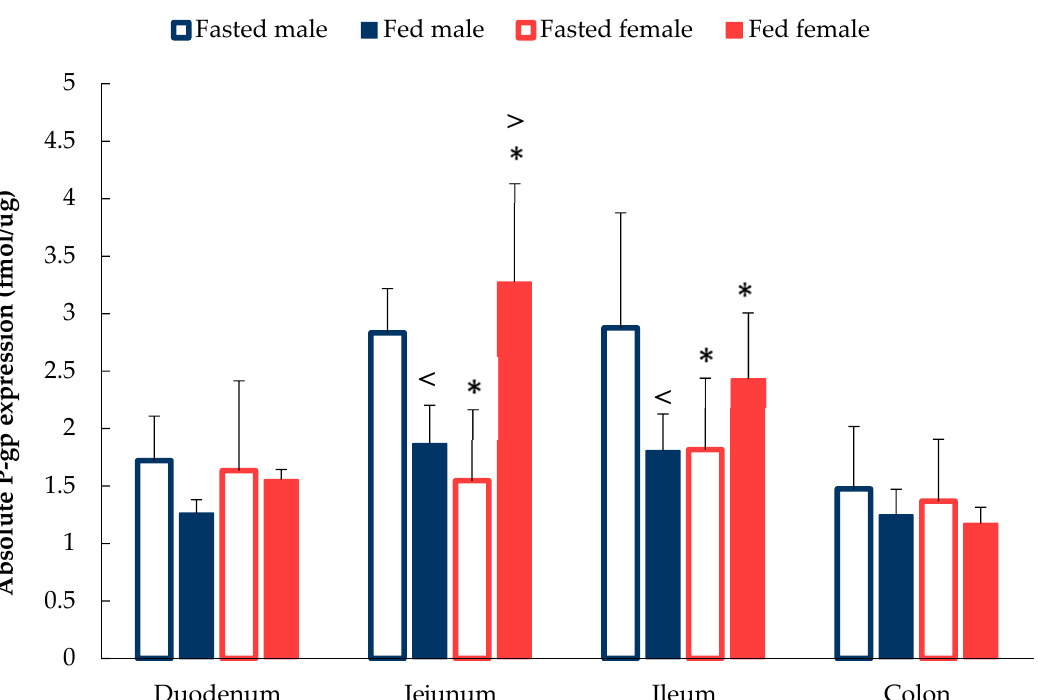
Figure 5. Absolute expression of P-gp along the intestinal tract in male and female rats under fasted and fed state. (Mean ± SD, n = 6). The following symbols (i) < denotes a statistical significance ( p < 0.05) between fasted and fed state in male rats, (ii) > denotes a statistical significance ( p < 0.05) between fasted and fed state in female rats and (iii) * denotes a statistical significance ( p < 0.05) between males and females in the same state.